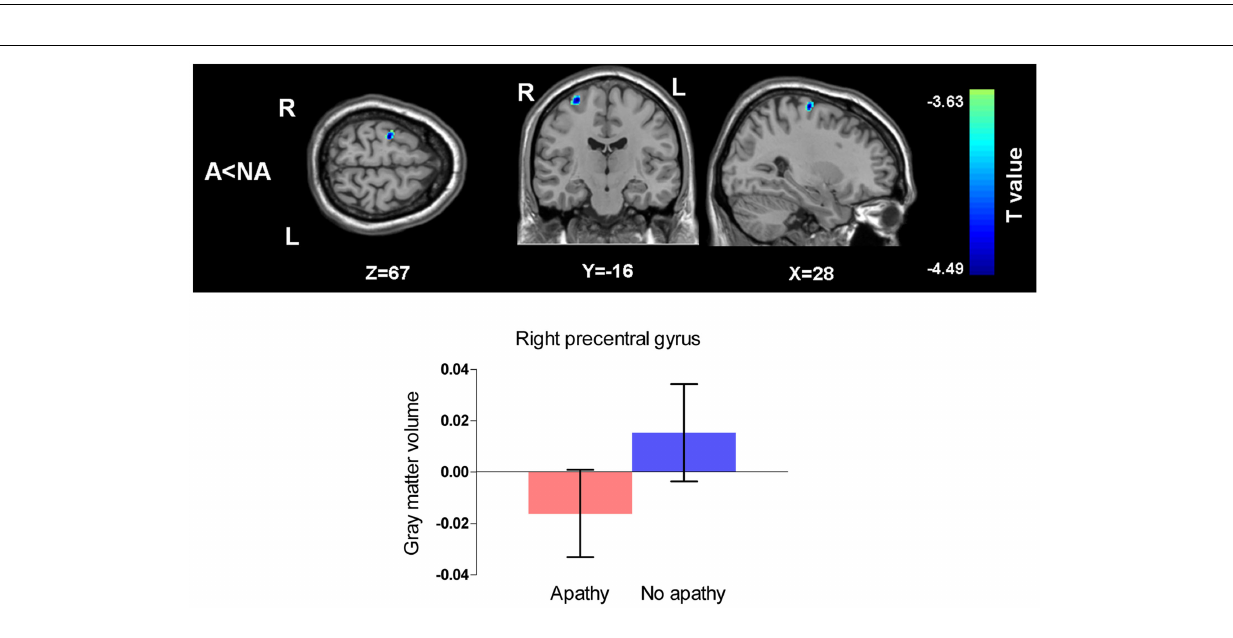
non-apathy group. Apathy group had decreased gray matter volume in the right precentral gyrus compared with non-apathy group. Error bars show 95% confidence